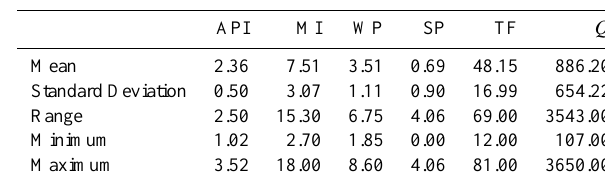
Table 1. Descriptive statistics of the data set used for the regression